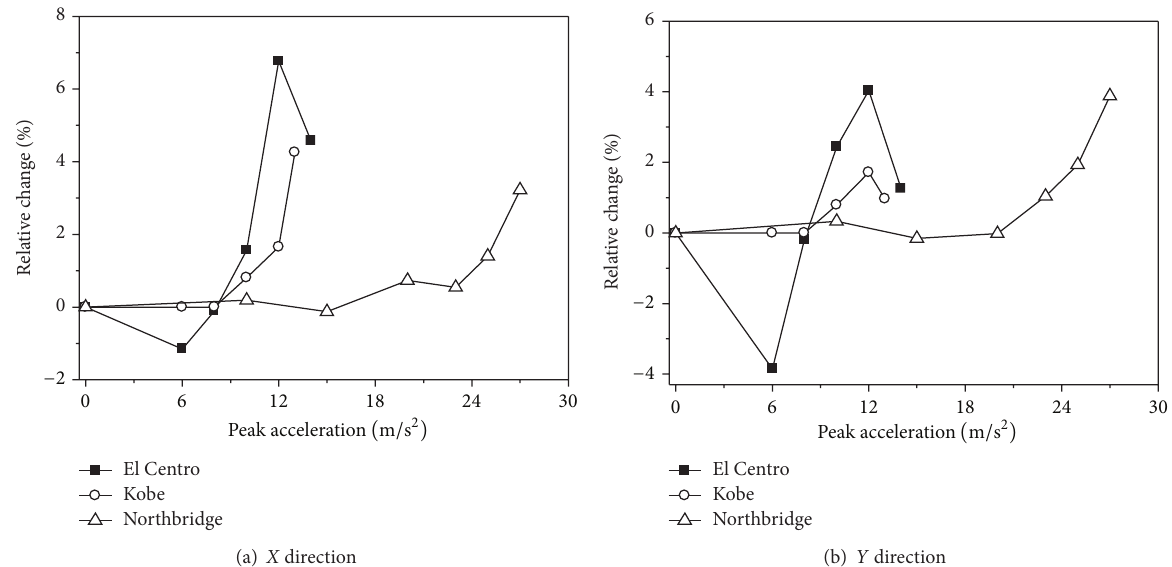
Figure 5: Relative changes of the maximum base shear forces of 2nd transmission tower.